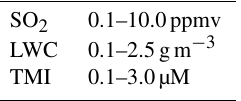
Table 5. Ranges of SO 2 , LWC and TMI explored in the sensitivity